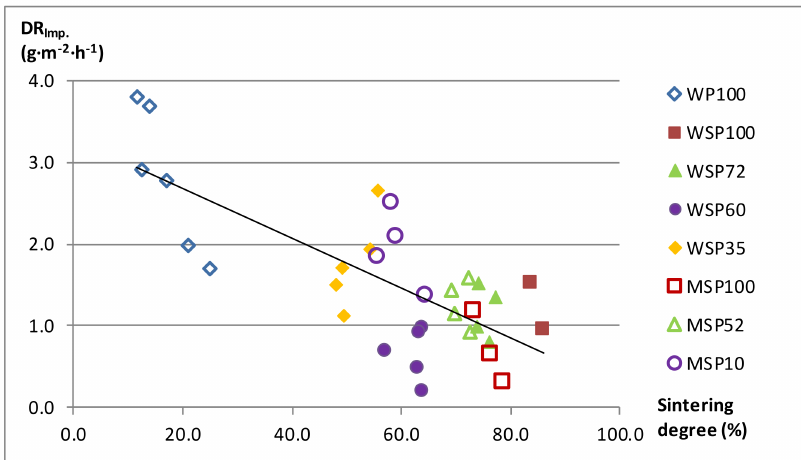
Figure 11. Deposition rates by inertial impact versus sintering